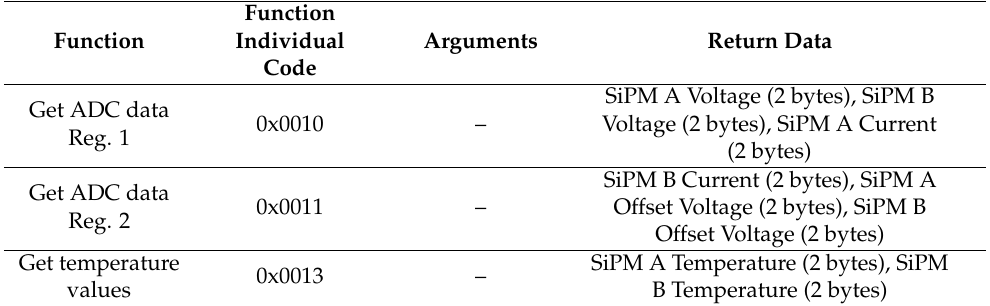
Table 5. List of CAN transactions for reading Voltage, Current, and Temperature values.